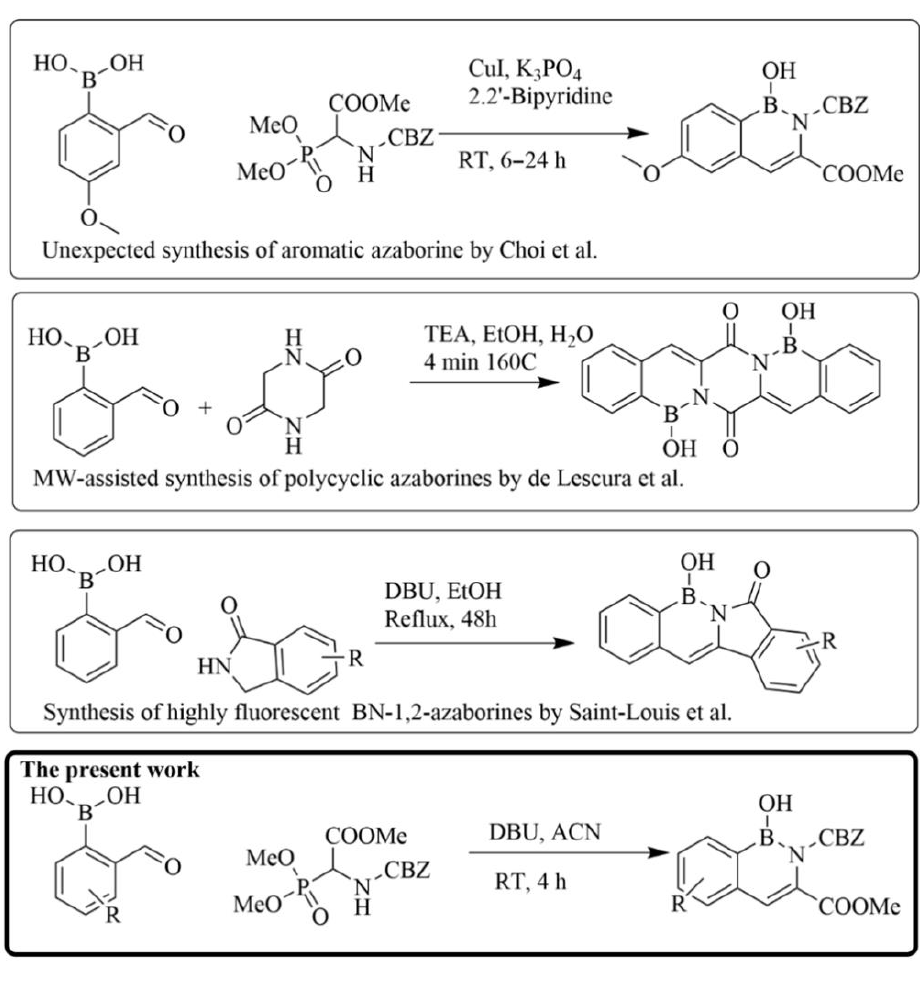
Figure 1. Earlier and present research on synthesis of aromatic azaborines [3,5 – 7].